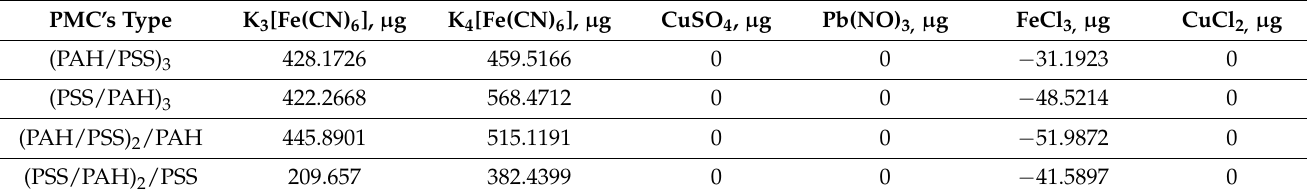
Table 2. The amount of adsorbate (salts of various metals) taken up by the various type of